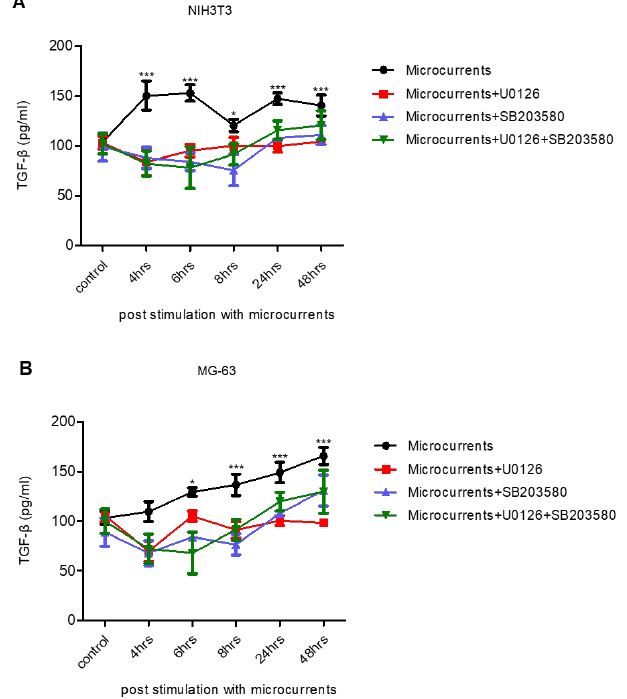
Figure 4. Fibroblasts and osteoblasts secrete TGF-β1 following stimulation with microcurrents. Quantification of TGF-β1 concentration in the supernatants from ( A ) NIH3T3 and ( B ) MG-63 cells stimulated with microcurrents, in the presence and absence of U0126 or SB203580 or the combination of both inhibitors, using ELISA. (* p < 0.05, *** p < 0.005, n = 3, n = 3, microcurrent stimulation vs. of both inhibitors, using ELISA. (* p < 0.05, *** p < 0.005, N = 3, n = 3, microcurrent stimulation vs. control).